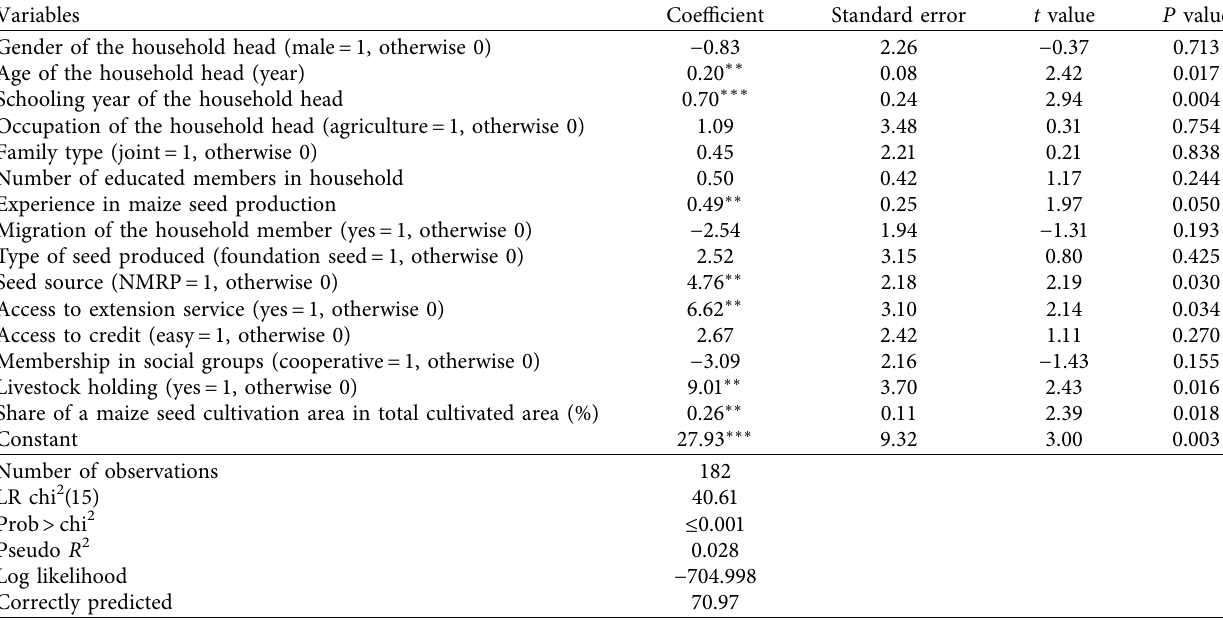
Table 5: Factors affecting technical efficiency using the Tobit model.